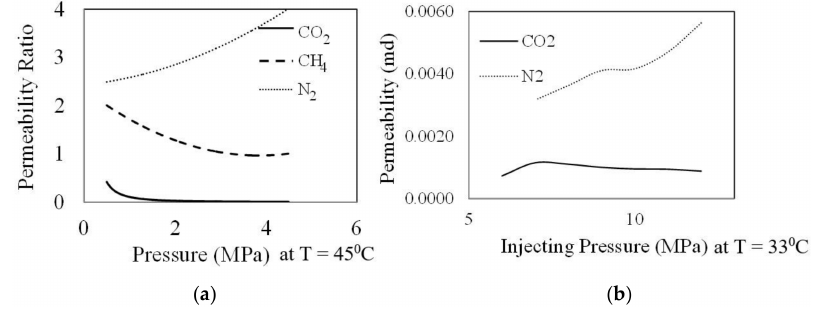
Figure 5. Unique flow behaviour of CO 2 in coal observed by different researchers. ( a ) Durucan and Shi [35]; ( b ) Perera et al.